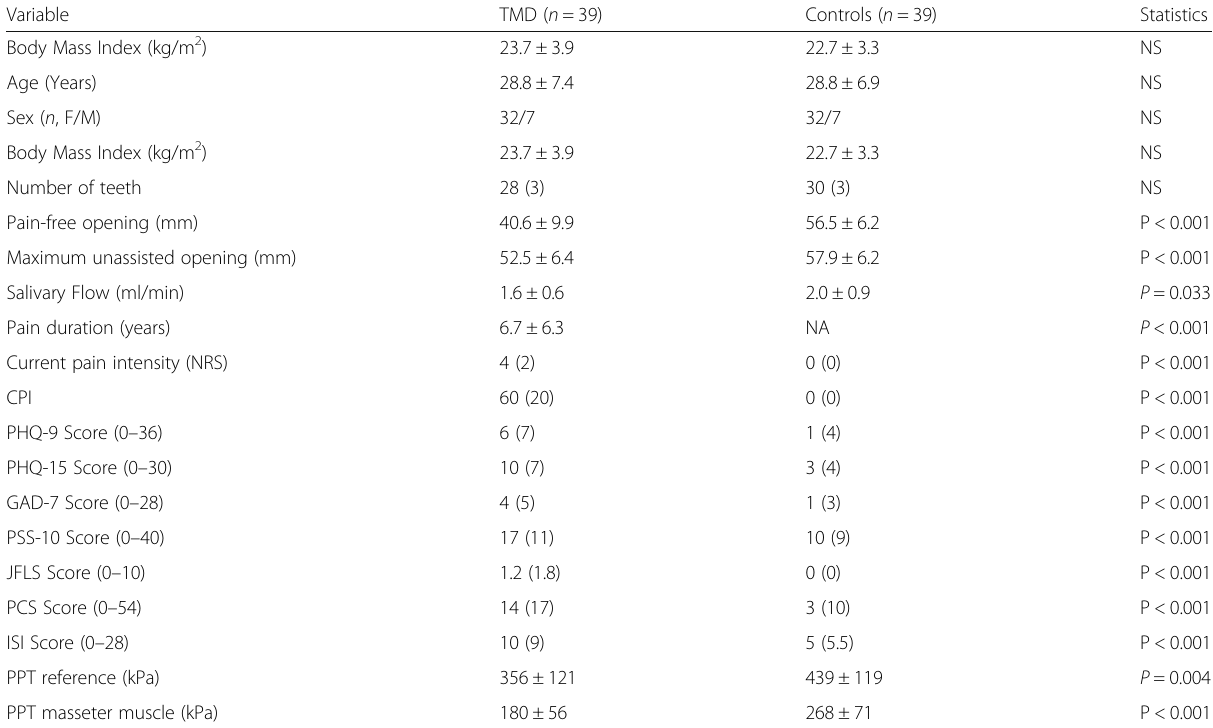
Table 1 Descriptive data. Demographic features of patients with temporomandibular disorders myalgia (TMD) and healthy controls. Questionnaire scores are presented as mean ± standard deviation or as median (interquartile range). Statistical analyses were performed with independent t-test or Mann – Whitney U-test, P <